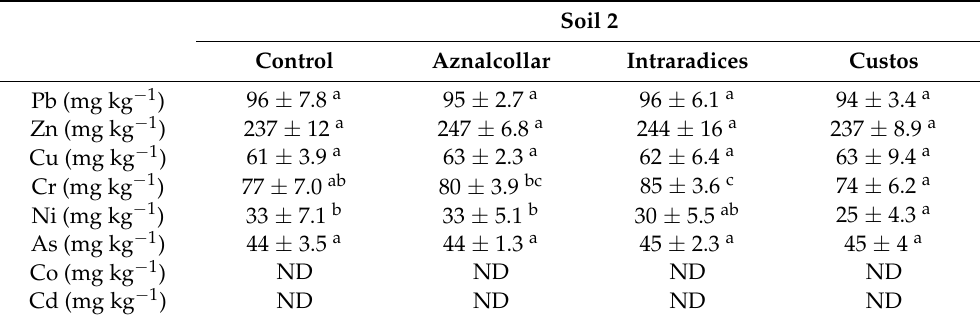
Table 2. Chemical characteristics of soil 2 (Control) inoculated with the three selected AMF (Aznal- collar, Intraradices, and Custos). Soil 2 Control